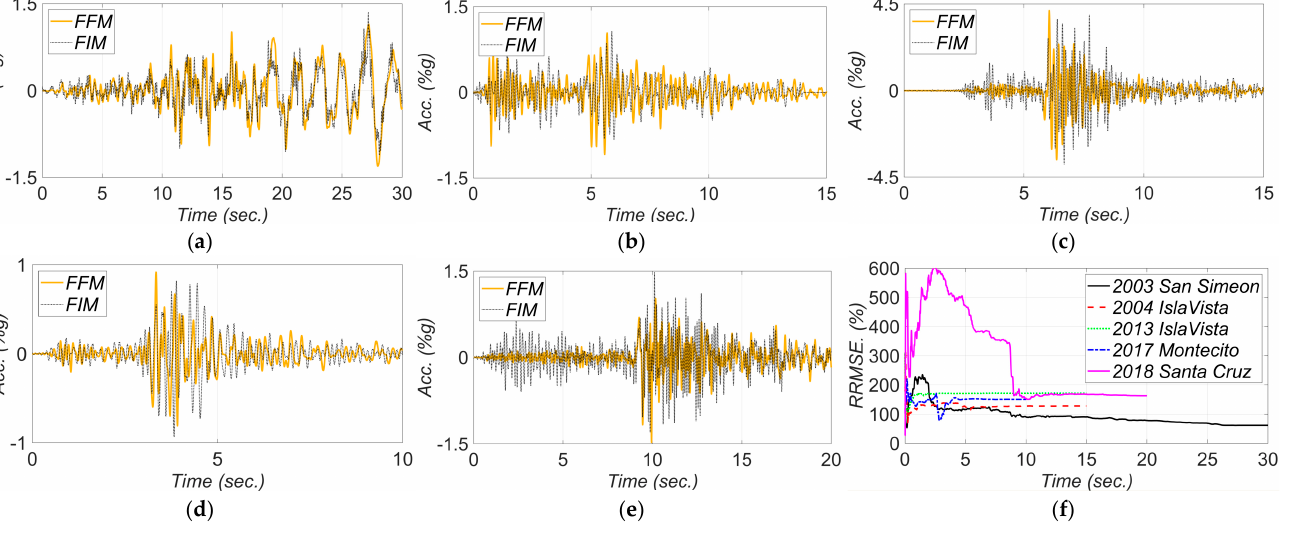
Figure 16. Comparison between the recorded FFMs and estimated FIMs in the transverse direction for ( a ) 2003 San Simeon, ( b ) 2004 IslaVista, ( c ) 2013 IslaVista, ( d ) 2017 Montecito, and ( e ) 2018 Santa Cruz, earthquake events. Part ( f ) is the RRMSE between the estimated FIMs and recorded FFMs.